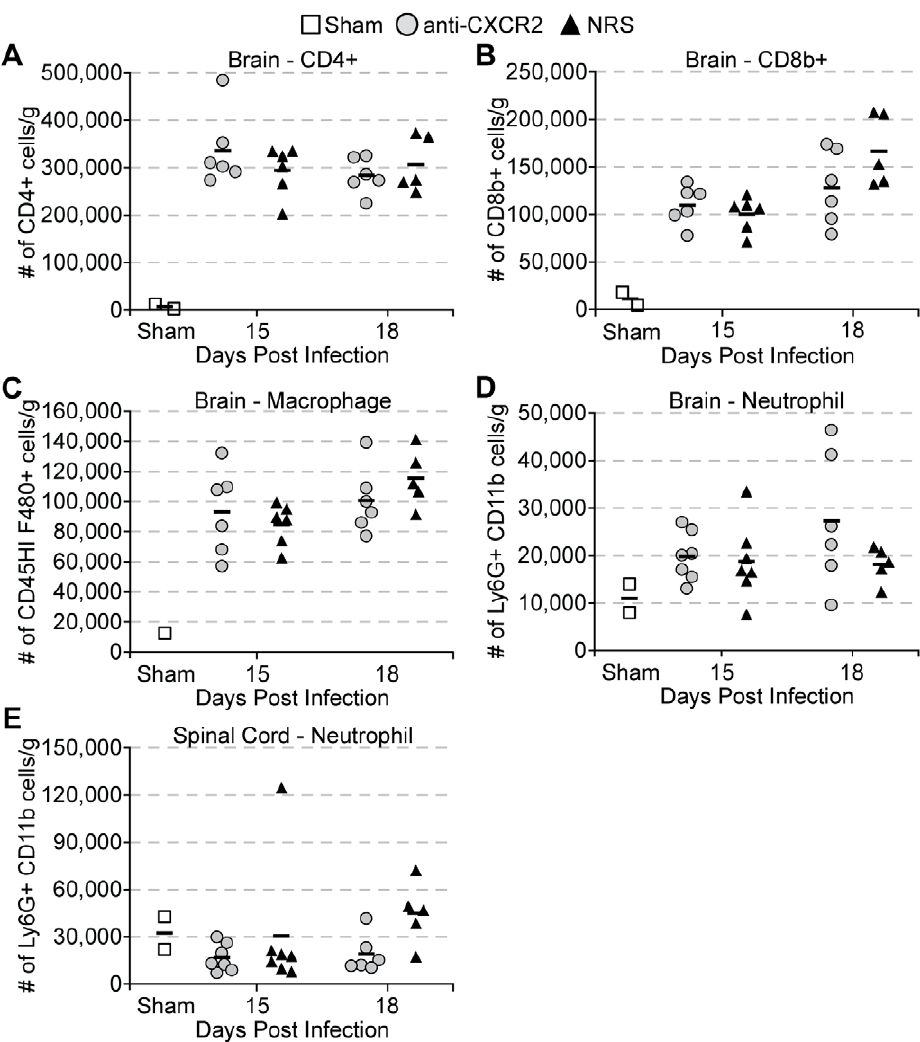
Figure 3. CXCR2 neutralization does not alter neuroinflammation during chronic JHMV infection. C57BL/6 mice were i.c. infected with 500 pfu JHMV and treated with neutralizing CXCR2 antiserum or control normal rabbit serum (NRS) i.p. from day 12 to 20. Brains ( A–D ) and/or spinal cords ( E ) were removed from perfused mice at defined times p.i. and were assessed for CD4 + ( A ), CD8 + T lymphocyte ( B ), macrophage ( C ), and neutrophil ( D & E ) accumulation within the CNS. Data in panels A – C are representative of four independent experiments, and data in panels D & E are representative of two independent experiments.